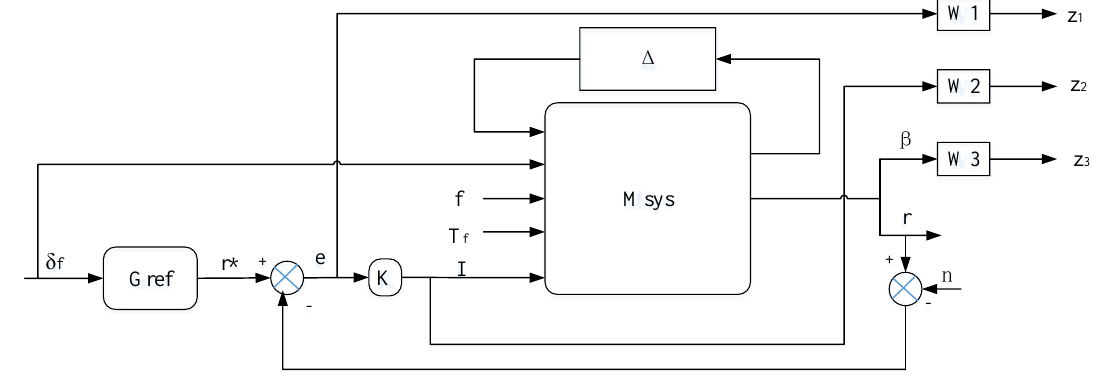
Figure 13. The stability control structure of the 4WS vehicle.